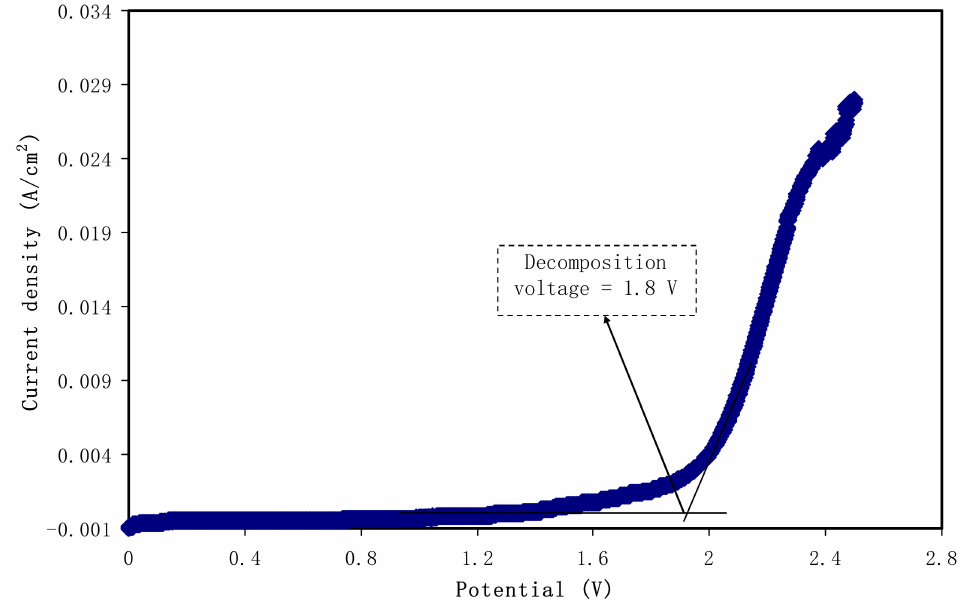
Figure 7. Linear sweep voltammetry (LSV) curve for the highest conducting